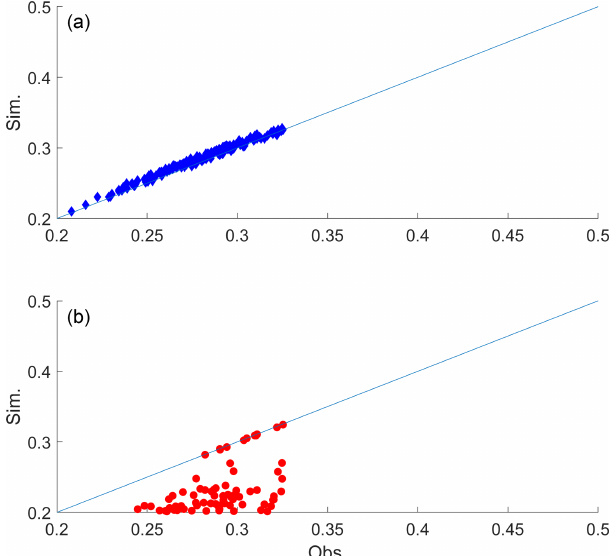
Figure 10. Scatterplot of lag-1 cross-correlations between 12 weather stations for the observed data ( x coordinate) and the gen- erated data ( y coordinate) from the DKNNR model (a) and the MONR model (b) with the whole-year data and not with the sum- mer season. The cross-correlations from 100 generated series are averaged.